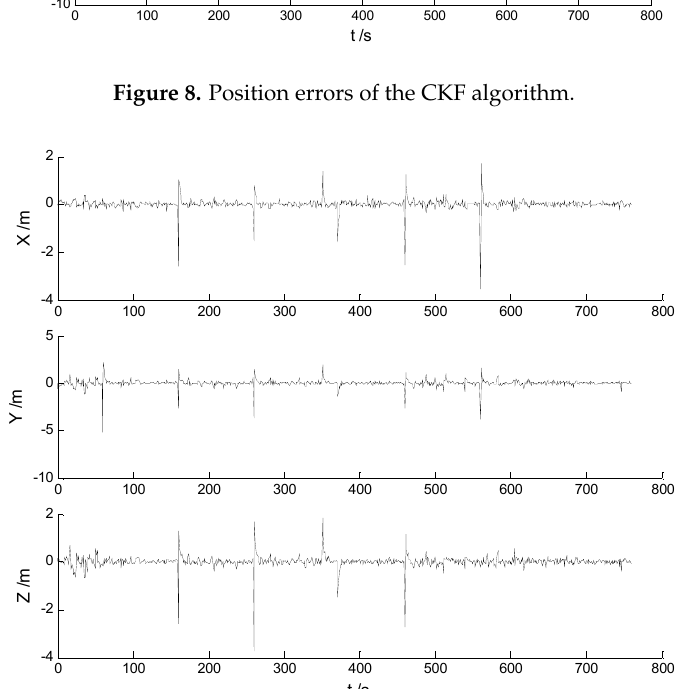
Figure 9. Position errors of the HF-CKF algorithm.